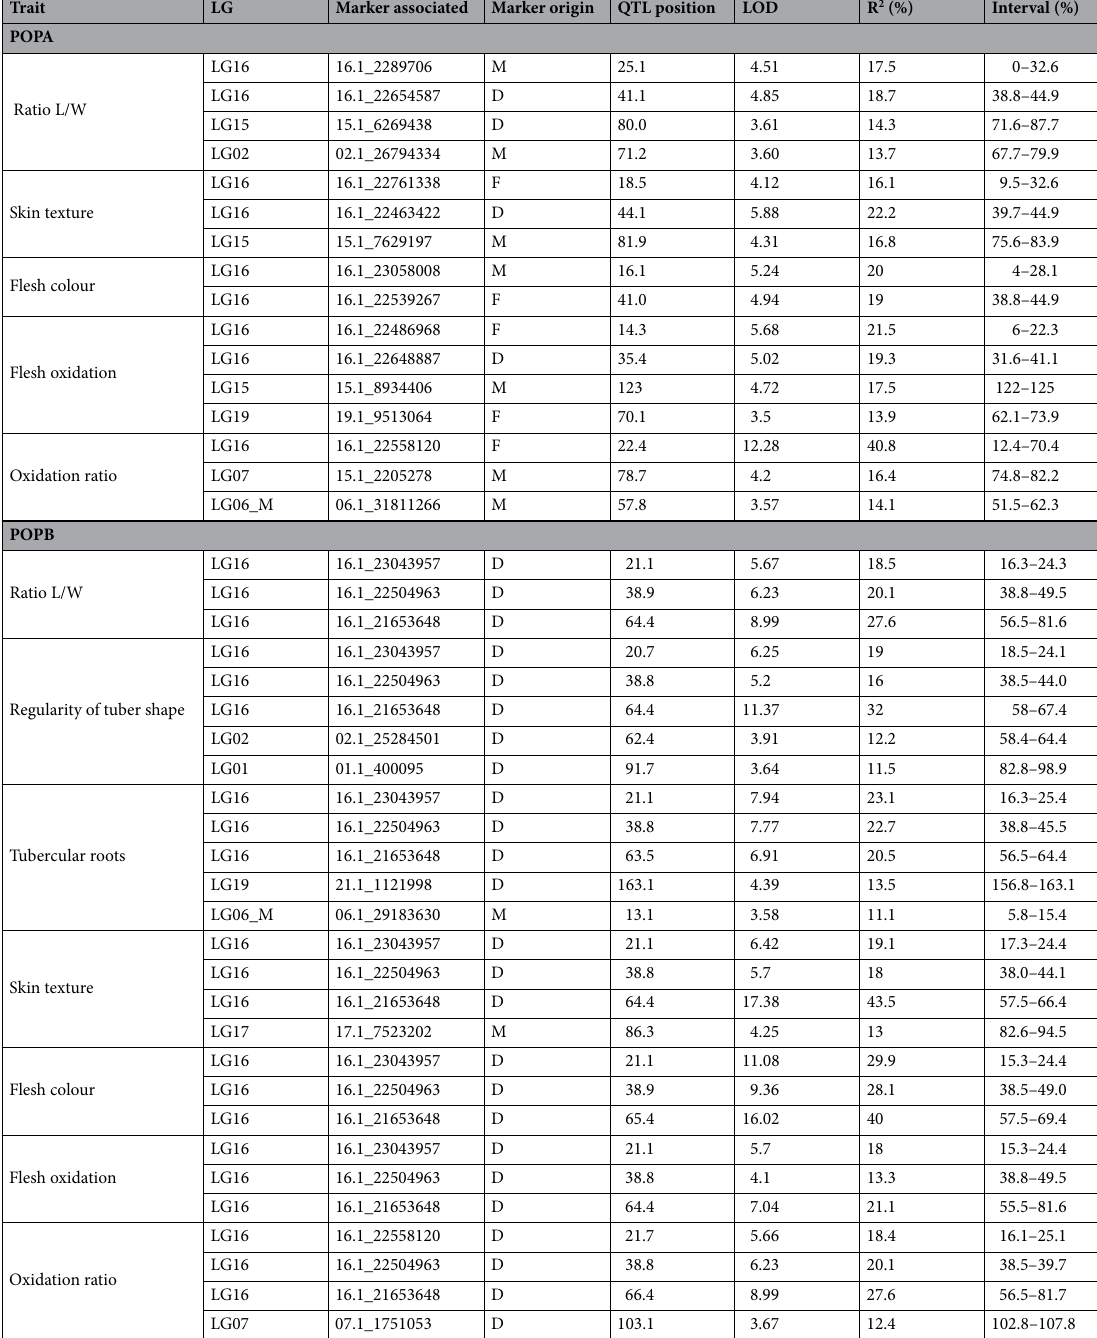
Table 5. QTL detected for mean (2018–2019) ratio length/width, skin texture, tubercular roots, shape regularity, flesh colour, flesh oxidation and oxidation ratio in the mapping populations A and B. LG linkage group, Marker associated closest marker to the highest LOD score, M inherited from male, F Inherited from female (74F), D inherited from both